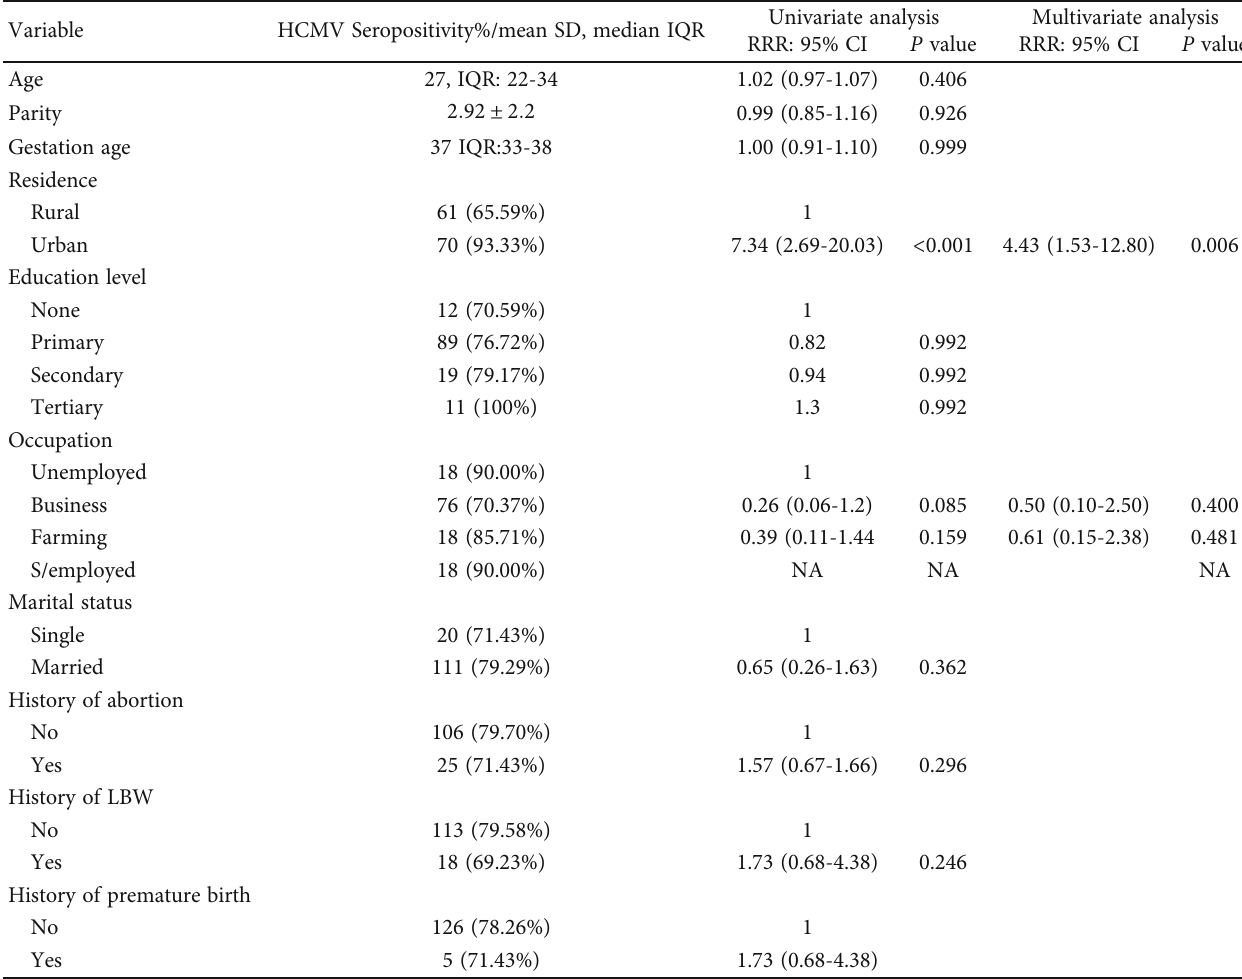
Table 4: Univariate and multinomial logistic regression analysis of the factors associated with HCMV IgG seropositivity among 168 women with stillbirth in Mwanza,